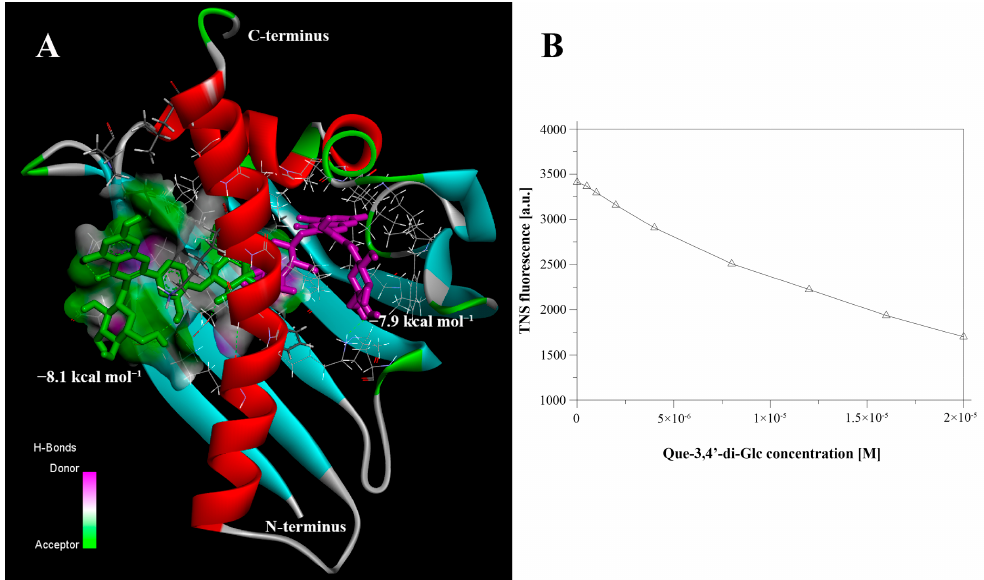
Figure 1. ( A ) Gly m 4 complexed with two best Que-3,4 (cid:48) -di-Glc conformations calculated by means of molecular docking. Green conformation has affinity energy − 8.1 kcal mol − 1 , magenta conformation − 7.9 kcal mol − 1 . ( B ) Que-3,4 (cid:48) -di-Glc binding to Gly m 4. Titration of 4 µ M Gly m 4 and 4 µ M TNS with Que-3,4 (cid:48) -di-Glc in 10 mM phosphate buffer, pH 7.4, 25 ◦ C. Fitting the data to Equation (1), IC 50 yields Kd of 30.2 ± 0.2 µ M for Que-3,4 (cid:48) -di-Glc. TNS was excited at 320 nm; the emission at 423 nm for Que-3,4 (cid:48) -di-Glc is